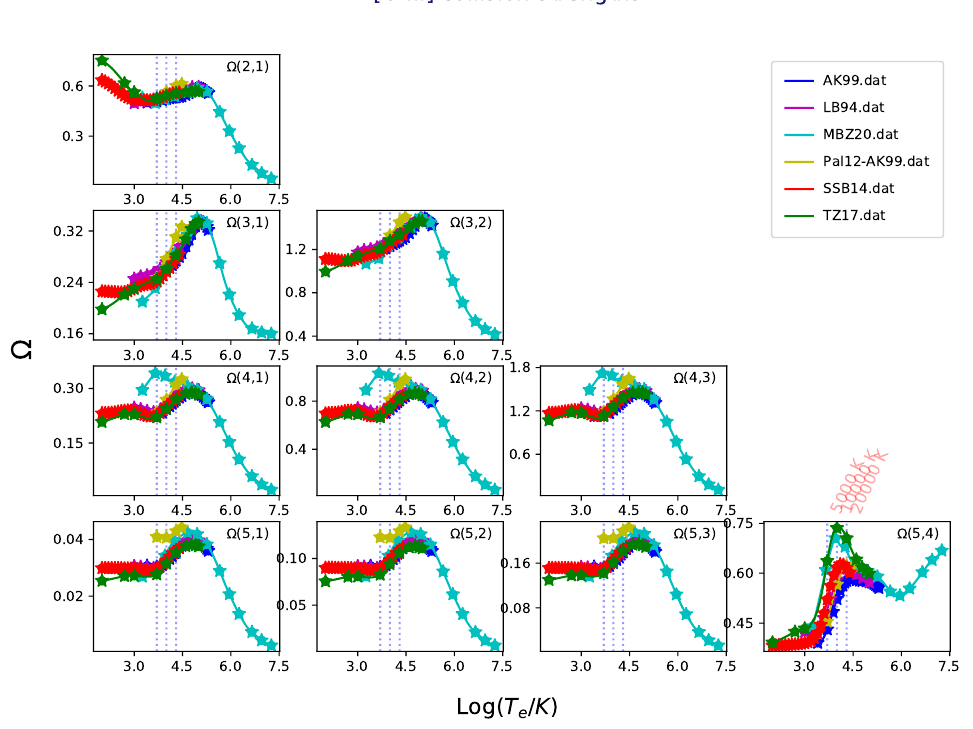
Figure 10. Available ECS for O III in PyNeb plotted with the plotOmega method of the DataPLot class. Note that “collision strengths” and Ω ( k , i ) in this figure stand for temperature-dependent